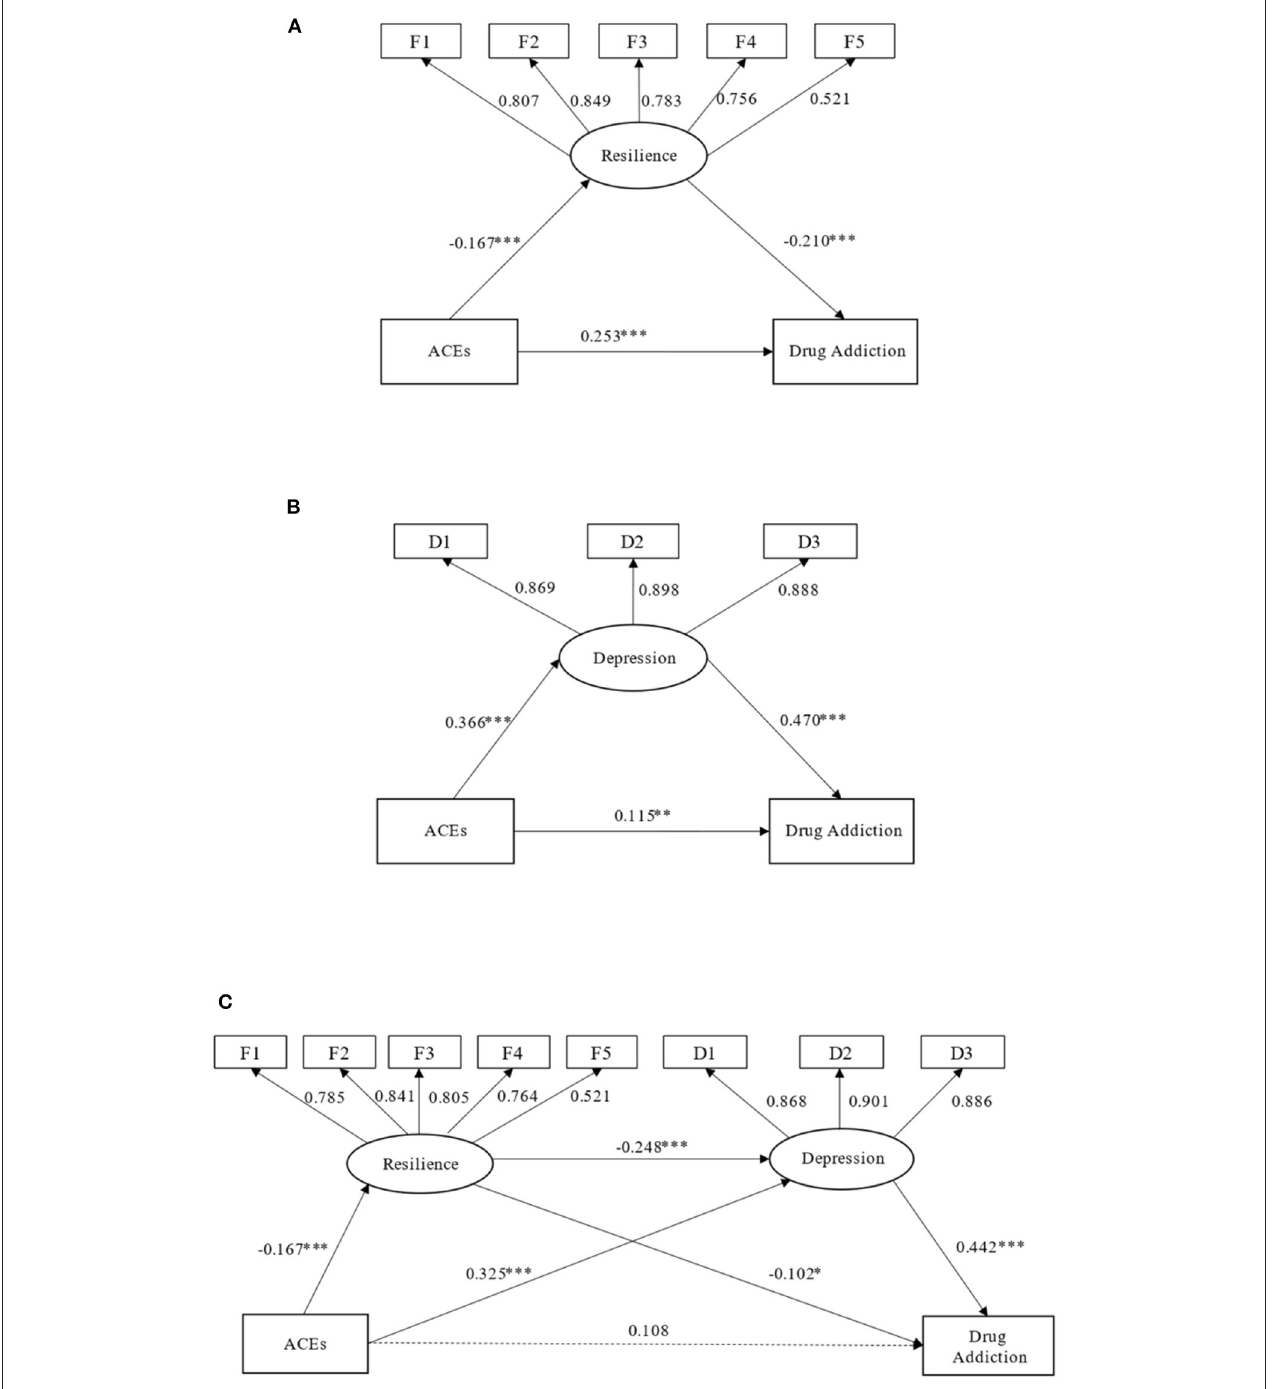
FIGURE 3 | Single-factor mediation models (Models 1 and 2) were established with resilience (A) or depression (B) as the mediator, respectively. Model 3 was established with resilience and depression as serial mediators (C) . Path coefficients are standardized. * p < 0.05, ** p < 0.01, *** p < 0.001.